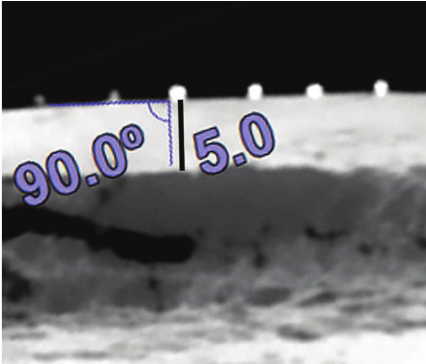
Figure 2: At right angle to the bone surface (90 ∘ ) the thickness of cortical point beneath the gutta percha is 5